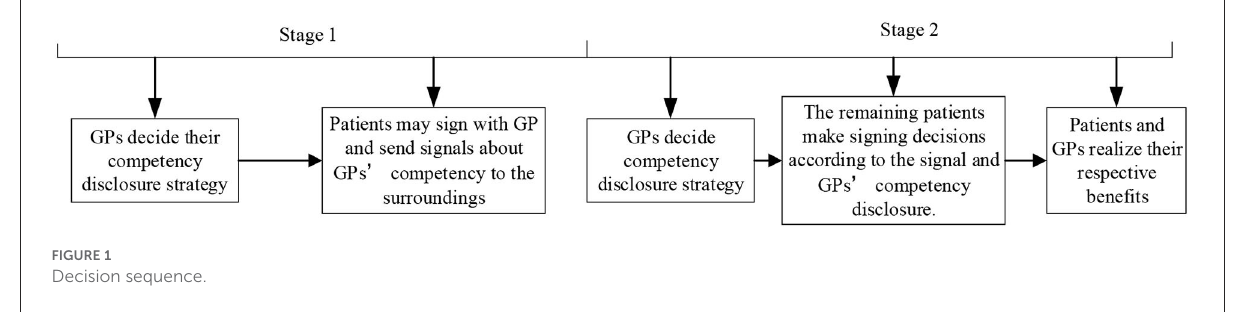
FIGURE1 Decision